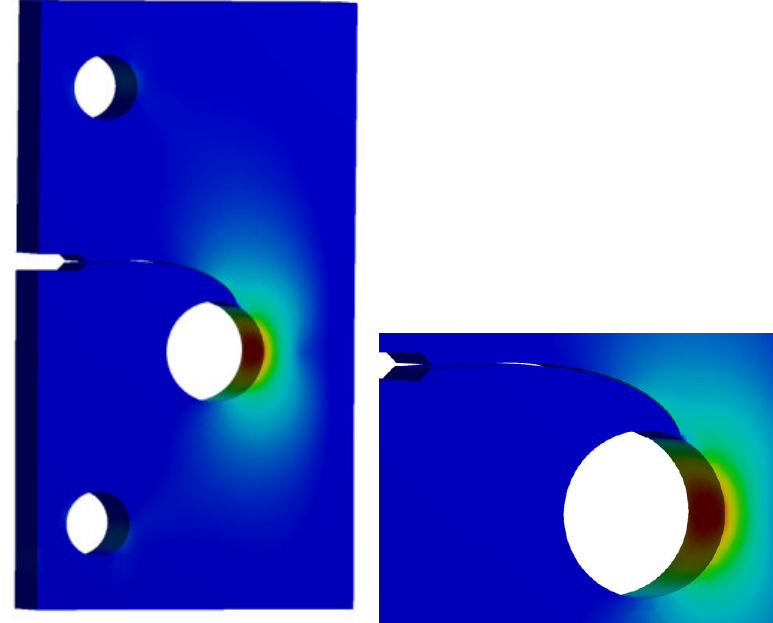
Figure 12. The maximum principal stress distribution.